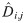
Contrast D^i,j for each pair of regions (i, j) in the atlas AAL computed between the ASD subjects and the controls (see (17)).